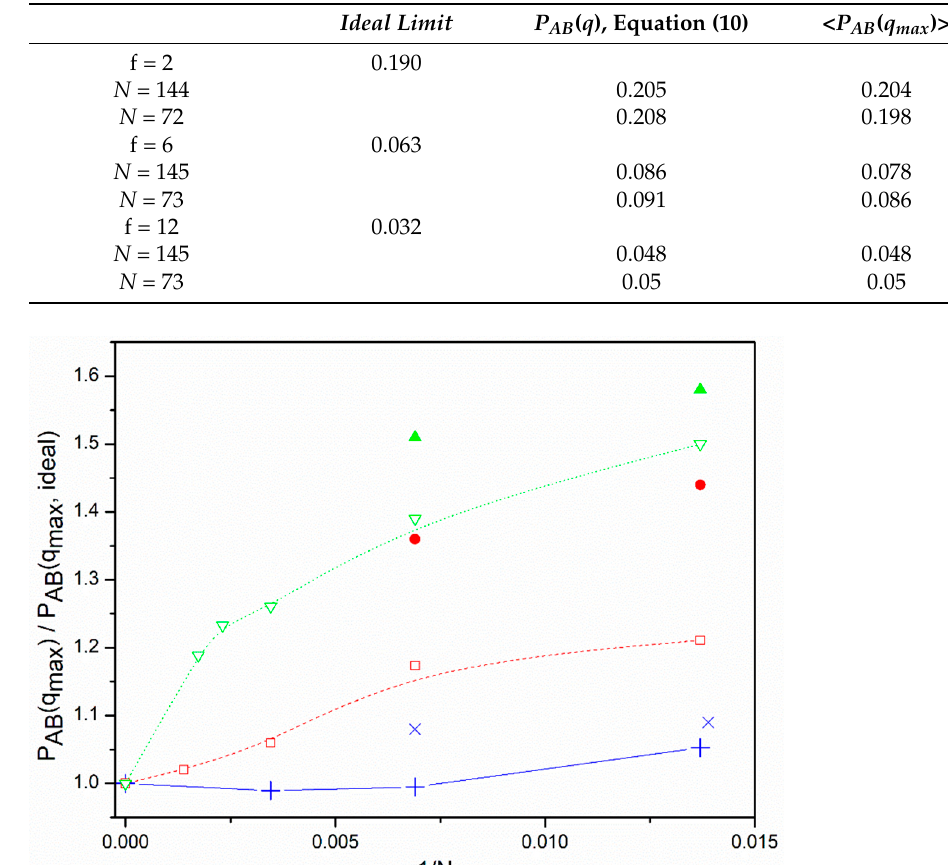
Figure 1. Ratio between the simulation form factors obtained from simulations with the higher density systems, Φ ∼ = 0.275, and the predictions for ideal chains. Results for single chains obtained with a non-lattice model: solid blue line and blue + crosses, f = 2; dashed red line and open red squares, f = 6; dotted green line and open green triangles down, f = 12. Results from simulation data obtained with the BFM and Equation (10), ε = 0: blue x crosses, f = 2; filled red circles: f = 6; filled green triangles up, f = 12.